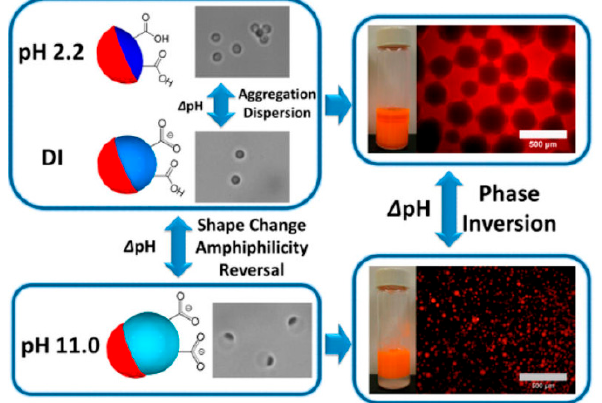
Figure 21. Janus particles change their aggregation/dispersion behavior and also transform into different shapes in response to pH changes. Janus particles with tunable amphiphilicity can stabilize different types of emulsions (oil-in-water and water-in-oil). Reprinted with permission from [144]. Copyright 2014, American Chemical Society.